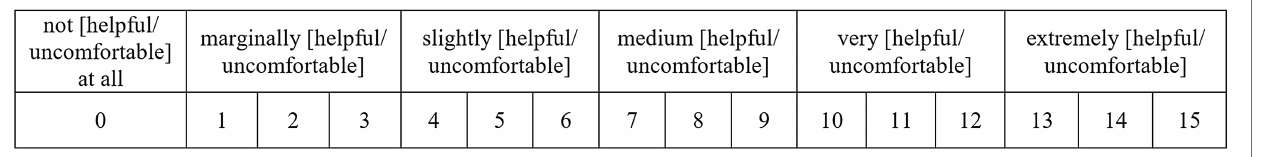
FIGURE 4 | Sixteen-point category subdivision scale used for the rating of system or situation after each situation and in the post inquiry for the example of “helpfulness” or